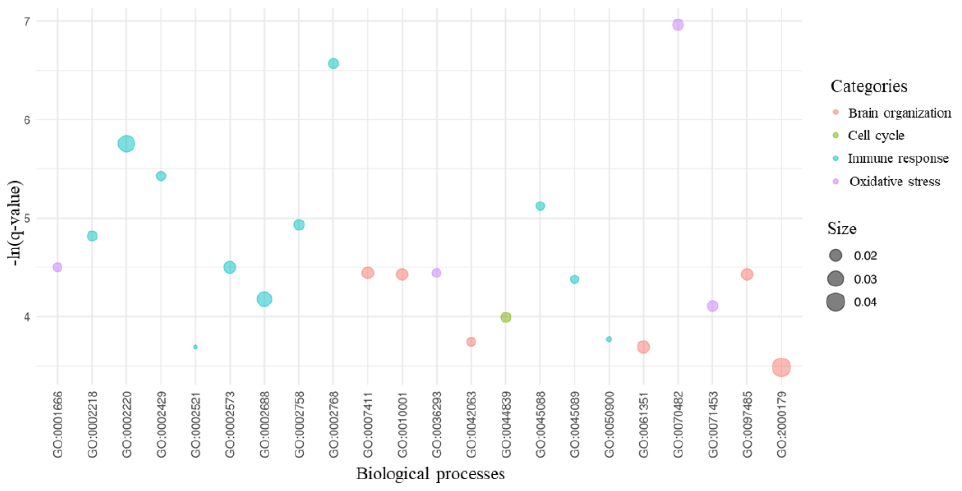
Figure 3. Biological processes of the key DEGs. For the 7 DEGs with the highest betweenness centrality and their 31 interactors, we provided the gene ontology enrichment of their biological processes. Among all the statistically significant processes, we kept the 22 processes related to brain organization, cell cycle, immune response and oxidative stress, as shown in the legend. On the x -axis are the gene ontology IDs of all the 45 processes. For each process, the score in the y -axis highlights its level of significance as -ln( q -value). The size of each bubble is proportional to the amount of DEGs implicated in the process compared to the number of genes known to be associated with the process itself.